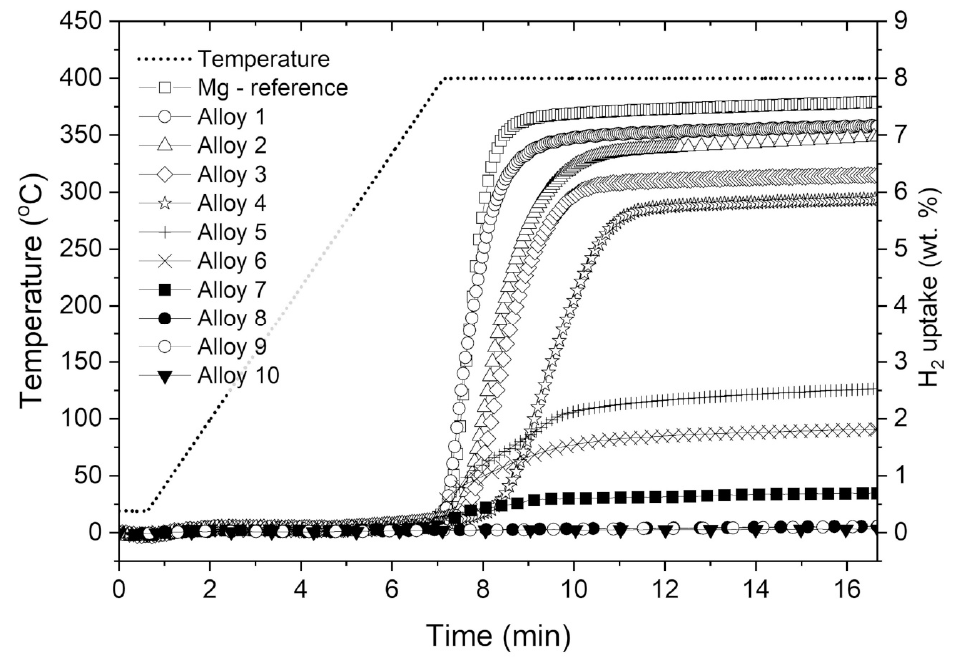
Figure 6. Comparison of the hydrogen absorption kinetics for the tested samples.